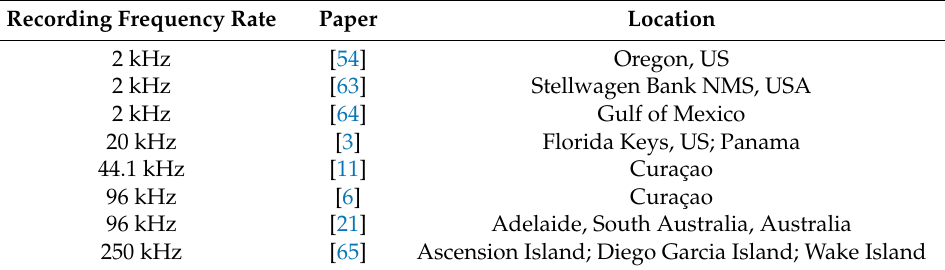
Table 2. Recording frequency rates used in various underwater soundscape ecology and/or long-term passive acoustic monitoring publications. NMS: National Marine